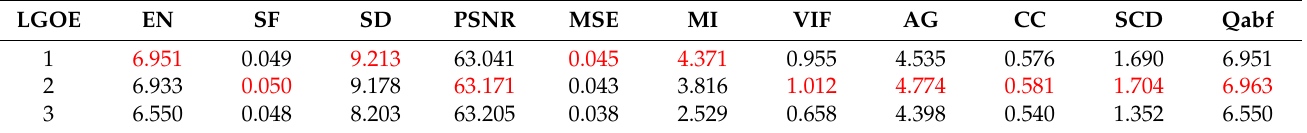
Table 4. The following is the fusion result of the number of cascades. Red is optimal and blue is suboptimal. Figure 11. Experimental results of a different number of couplets, ( a ) 1, ( b ) 2;( c ) 3.